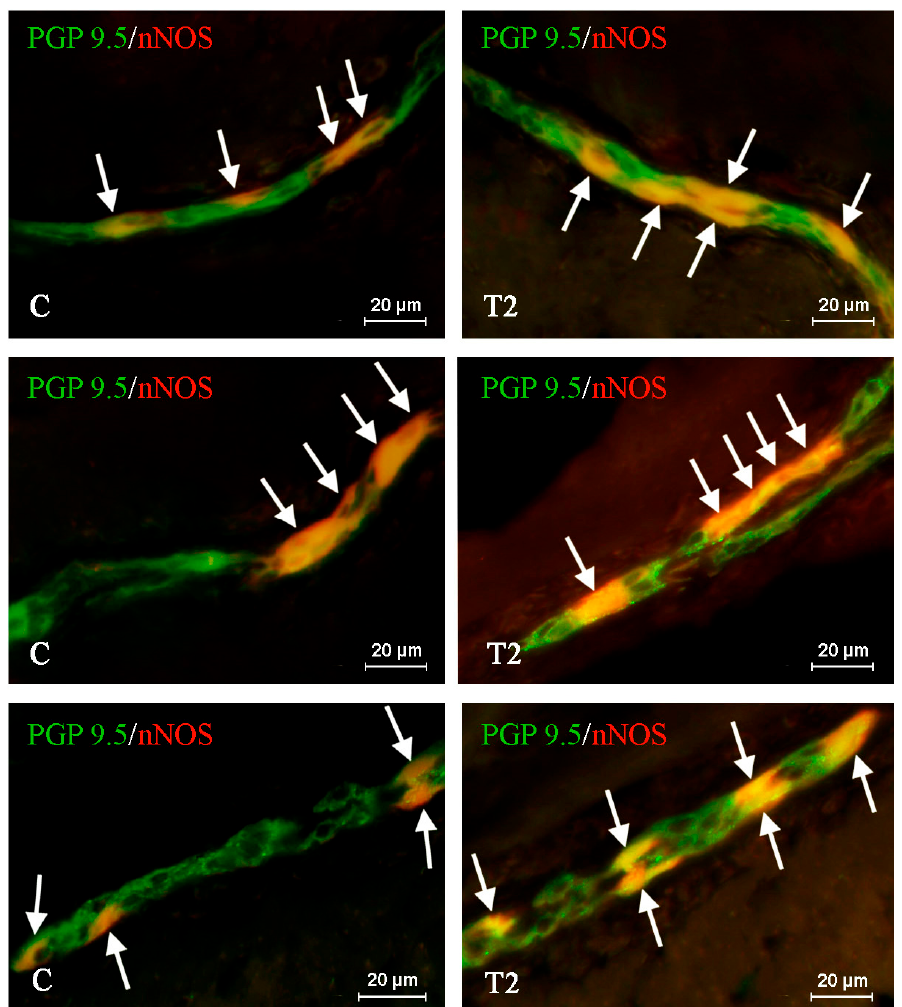
Figure1. Distributionpatternofnervecellsimmunoreactivetoproteingene-product9.5(PGP9.5)—used as pan neuronal marker and neuronal isoform of nitric oxide synthase (nNOS) in the myenteric plexus of porcine duodenum under physiological conditions (C) and after T2-toxin administration (T2); the pictures are the result of the overlap of both stainings. The arrows point to neurons immunoreactive for both PGP 9.5 and